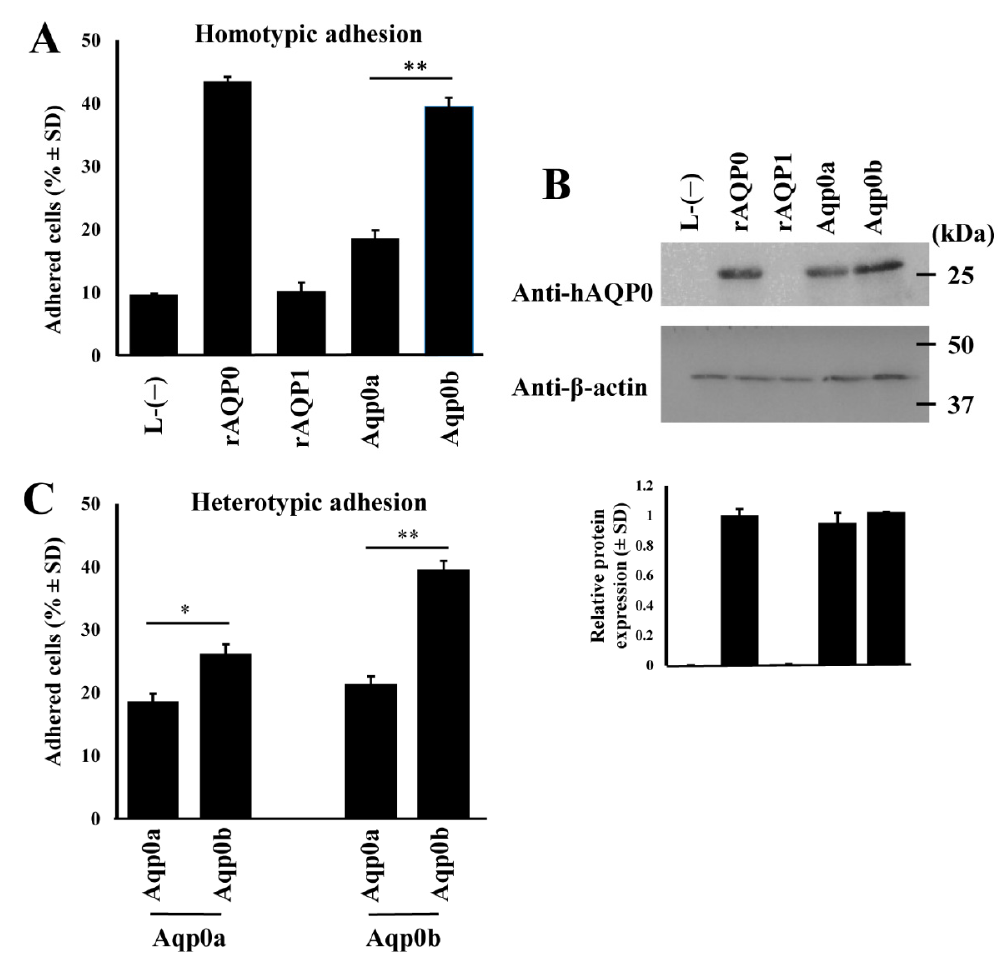
Figure 1. Zebrafish Aqp0b has adhesive properties. ( A ) Adherent cell percentages are shown for homotypic pairs of stable cell lines expressing positive control rat AQP0 (rAQP0), negative control rat AQP1 (rAQP1), zebrafish Aqp0a or Aqp0b, as well as cells transfected with an empty vector (L-( − )). Each lane represents n = 6–8. ( B ) Similar expression levels of rat AQP0 and zebrafish Aqp0 proteins shown by Western blotting using an anti-human C-terminus AQP0 antibody, and an anti- β -actin antibody as the loading control. Sample blot, top panel; quantification, bottom panel ( n ≥ 3). ( C ) Heterotypic adhesion tested between zebrafish orthologs. Aqp0 plated first is indicated at the bottom. Statistical differences are shown as * having p < 0.05 or as ** having p < 0.01.